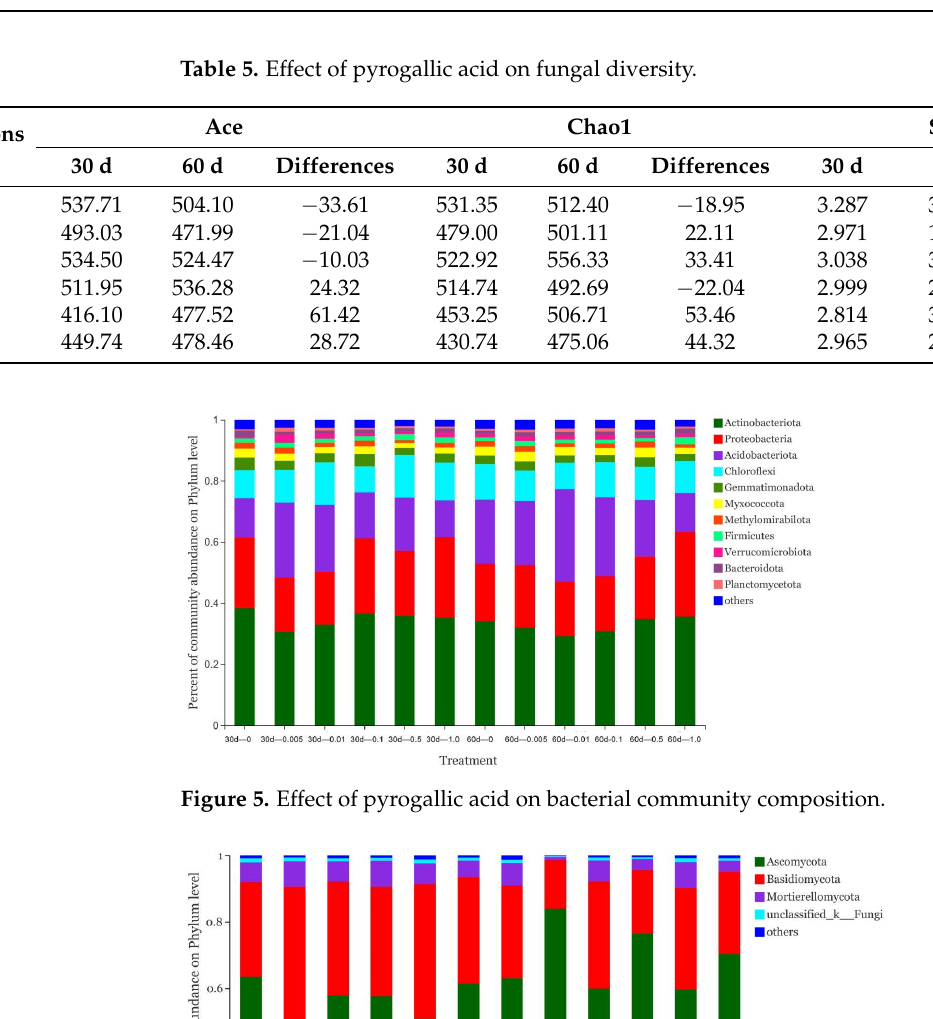
Table 6. Correlation analysis between cumulative CO 2 release and soil microbial diversity after cat ‐ echol addition. Bacteria